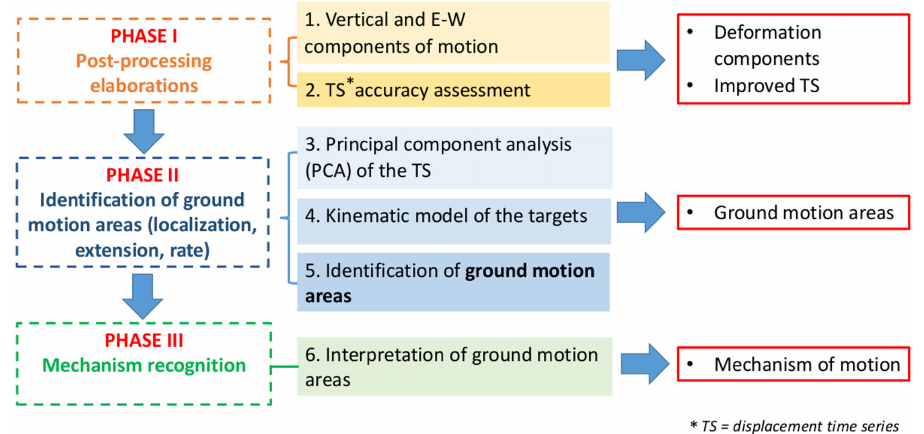
Figure 3. Flowchart of the methodological approach to detect ground motion areas and to recognize the triggering mechanisms.